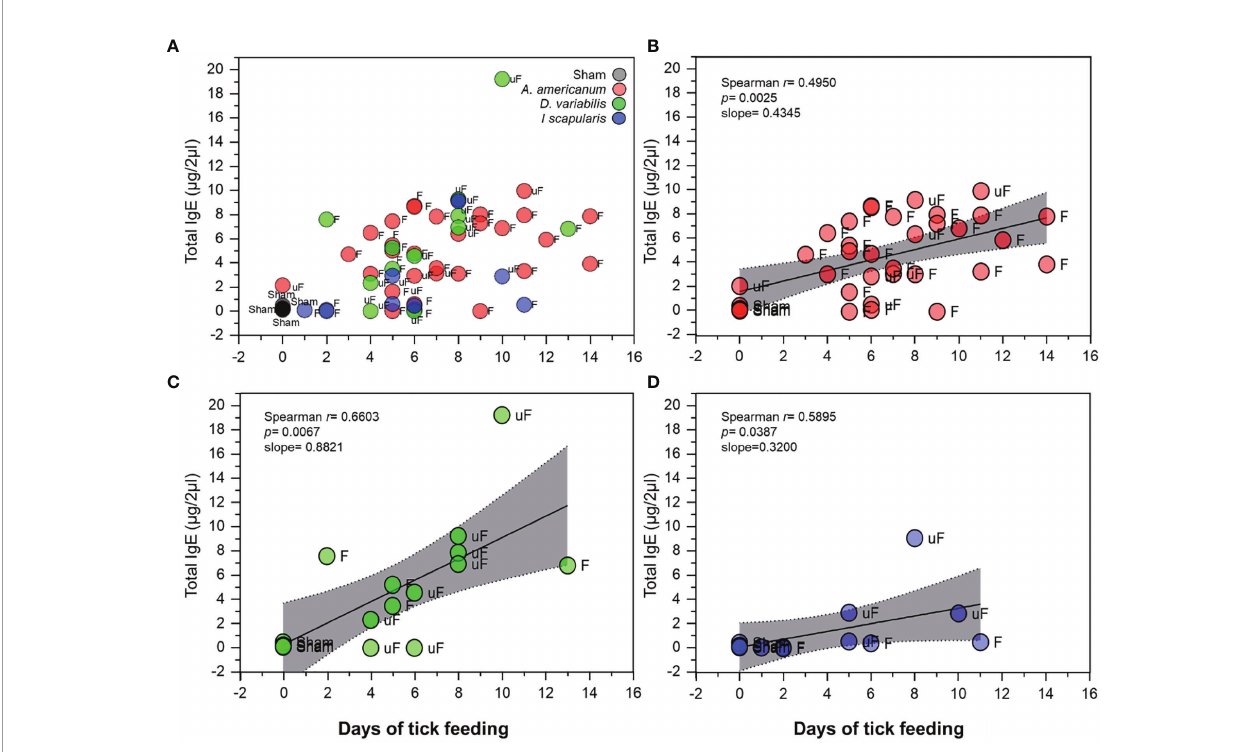
FIGURE 5 | Correlation of total IgE levels with days of tick feeding. (A) Scatterplot showing total IgE levels (in µg/2µl of serum) in relation to days of tick feeding among the different treatments and tick species used. Gray; sham, Red; A . americanum , Green; D . variabilis and Blue; I . scapularis . Data labels; F; fed, uF; unfed. (B) Spearman ’ s rank correlation plot with linear regression, of A . americanum with days of tick feeding. (C) Spearman ’ s rank correlation plot with linear regression, of D . variabilis with days of feeding and (D) Spearman ’ s rank correlation plot with linear regression, of I . scapularis with days of feeding. Plots show positive correlation and linear regression slope. The gray shaded area represents the 95% con fi dence